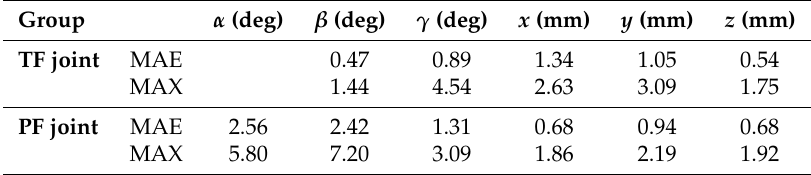
Figure 3. The subject-specific motion versus the TF flexion angle: experimental motion (black dashed lines) superimposed to the corresponding from the kinematic model (solid blue lines lines). Red circles highlight the point with the highest discrepancy between the experimental and the model motion. The pale blue areas around the experimental motion represent the theoretical accuracy of 3DV provided by Fregly [36]: they are centered with respect to the values of the experimental motion augmented by 3DV bias (i.e., the the mean value of the theoretical error between the 3DV and the experimental motion) with a width equal to the 3DV precision (i.e., the standard deviation of the theoretical error between the 3DV and the experimental motion). Table 2. Mean absolute (MAE) and maximum absolute (MAX) errors of the pose parameters of the TF and PF joints. Group α